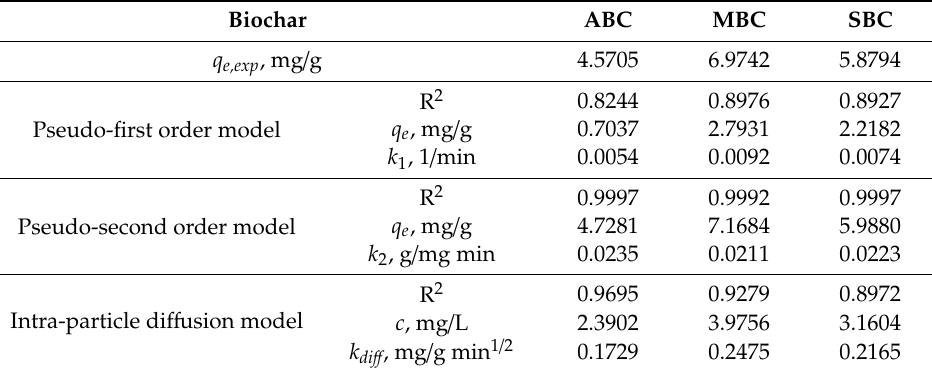
Table 3. Kinetics parameters for the sorption of Co(II) ions on the three types of biochars.